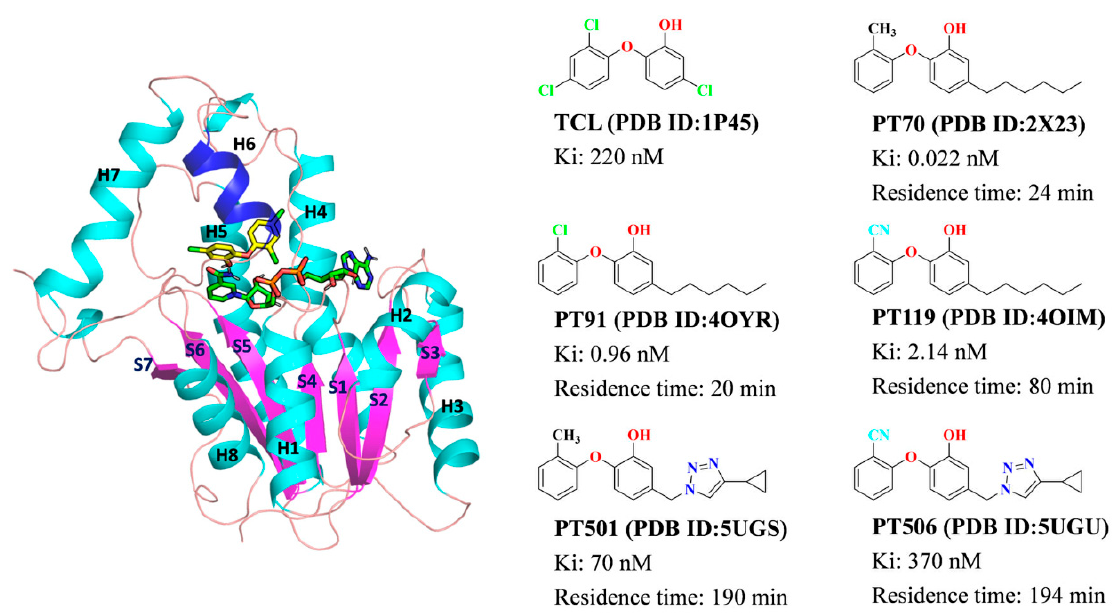
Figure 9. The binding mode of InhA with TCL ( left ); the chemical structures of the studied six inhibitors as well as their crystal structures with InhA: TCL (1P45 [29]), PT70 (2X23 [30]), PT91 (4OYR [6]), PT119 (4OIM [5]), PT501 and PT506 (5UGS, 5YGU [31]) ( right ). The β -sheet (S1–S7) was colored with magenta cartoon, the α -helix (H1–H8) was colored with cyan cartoon and the loop region was colored with pink.